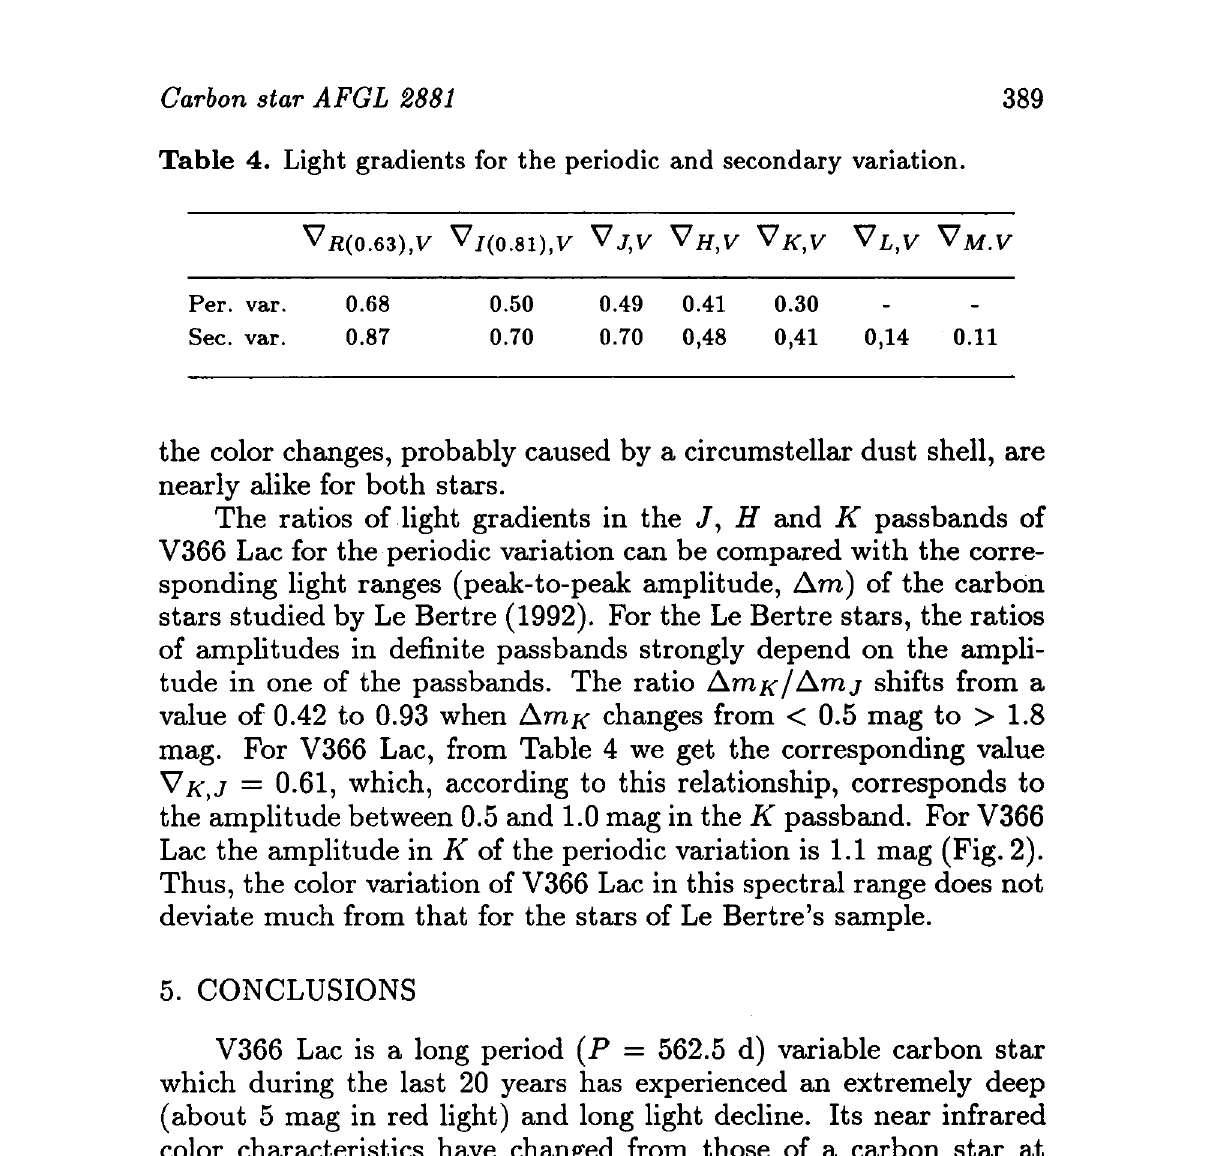
Table 4. Light gradients for the periodic and secondary